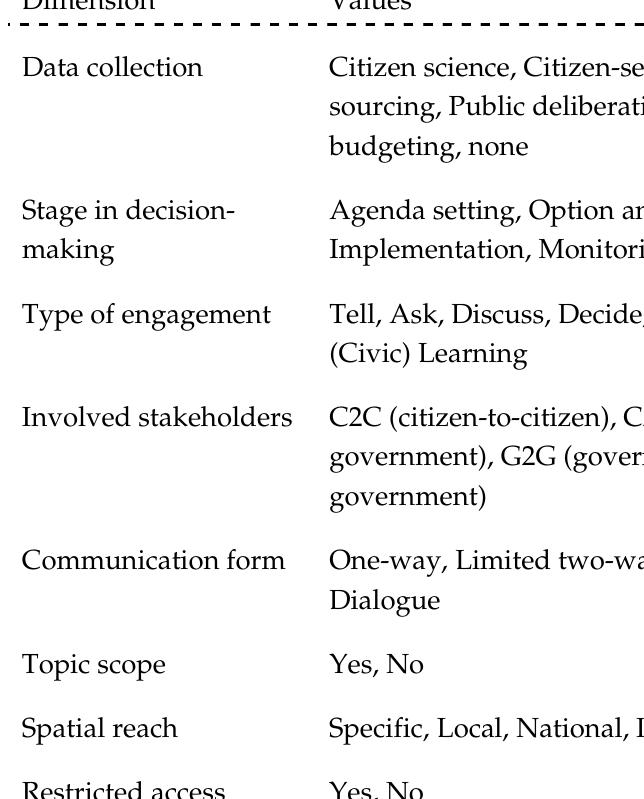
Table 1: The Participation-Related Dimensions (First Axis) Dimension